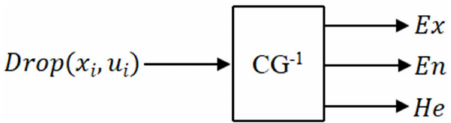
Figure 2. Inverse cloud generator.